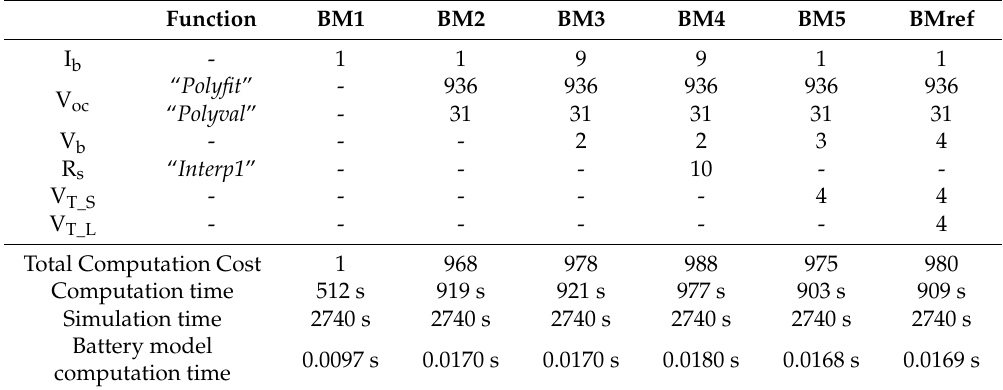
Table 4. Computational Cost of the Different Battery Models.